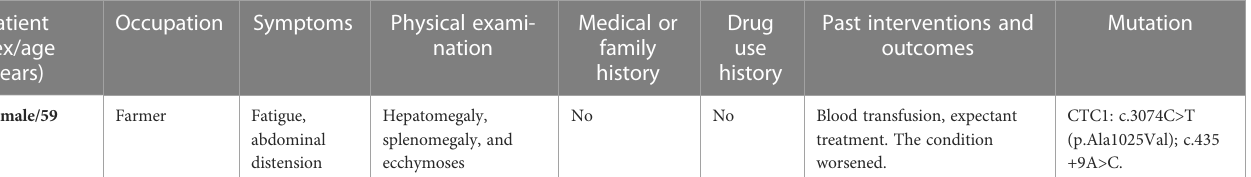
TABLE 1 Clinical characteristics of the patient.